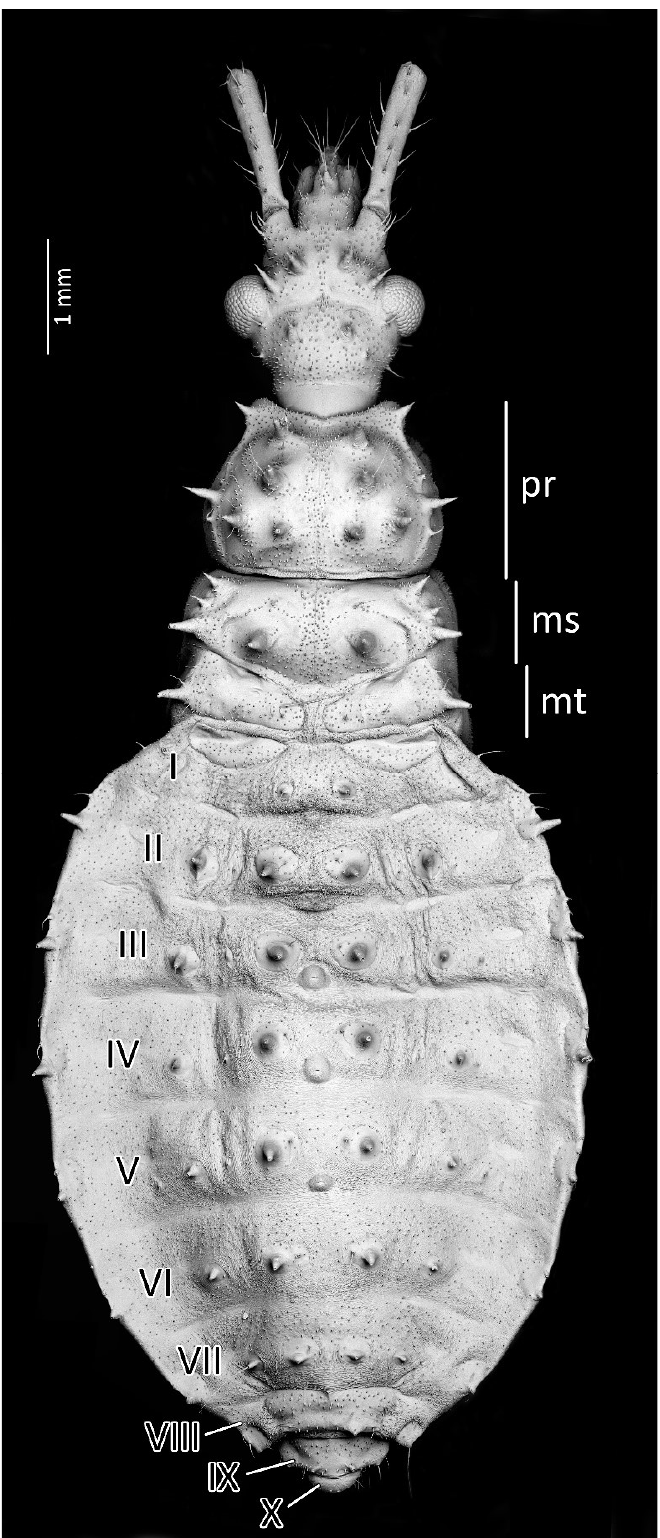
Figure 8. Dorsal habitus of the second instar of Psyttala horrida (Stål, 1865), detailed SEM view. ms —mesonotum; mt —metanotum; pr —pronotum; I – X —abdominal segments. Measurements (in mm): Body length 10.8–11.5; maximum width of abdomen 4.64– 4.75; head length 2.26–2.38; head width 1.16–1.21; length of anteocular portion 1.11–1.14; length of postocular portion 0.72–0.75; length of synthlipsis 0.92–0.95; length of antennal segments I, II, III, and IV are 0.98–1.1, 2.5–2.7, 4.13–4.17, and 3.69–3.78, respectively; length